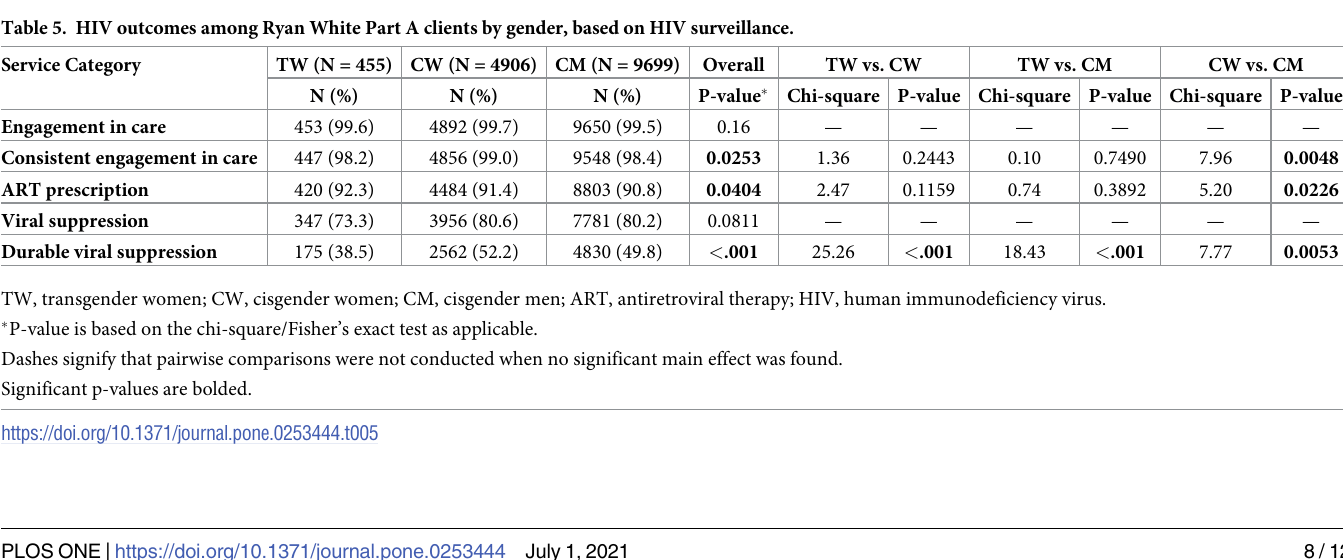
Table 5. HIV outcomes among Ryan White Part A clients by gender, based on HIV surveillance. Service Category TW vs. CW